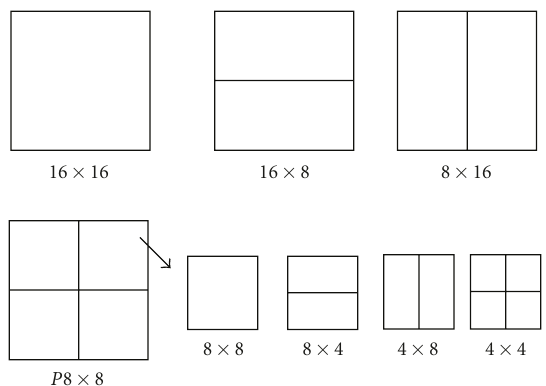
Figure 1: Various block sizes of inter mode prediction.